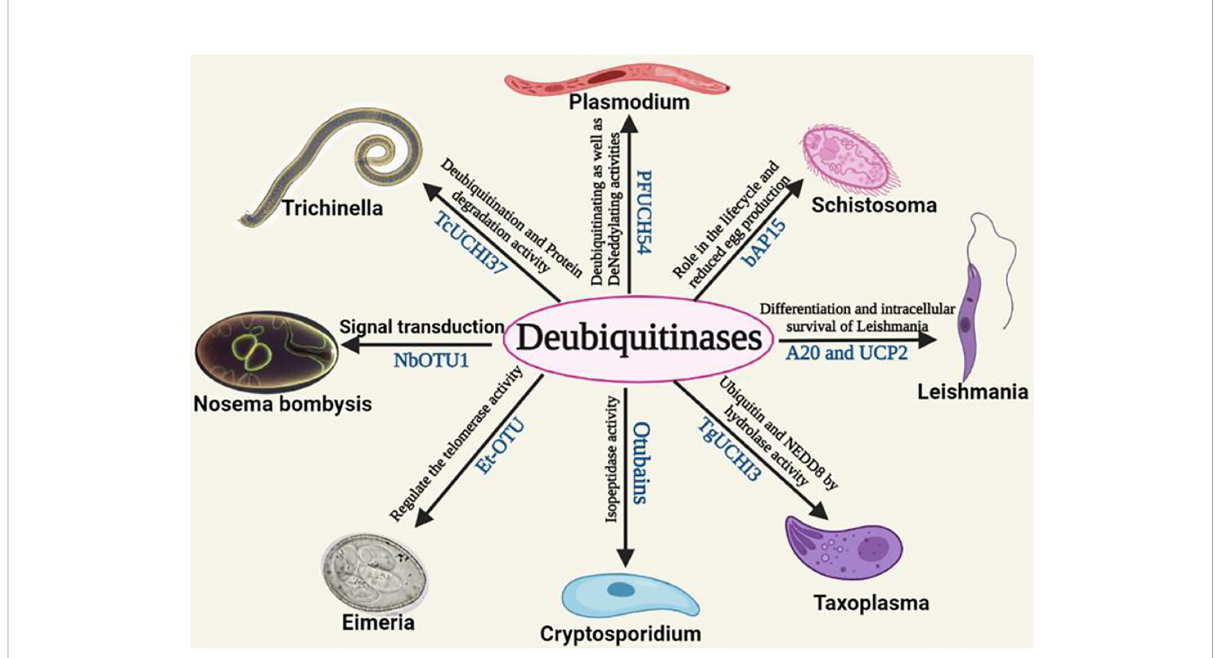
FIGURE 3 The role of different deubiquitinases with their respective domains showing different functions in the